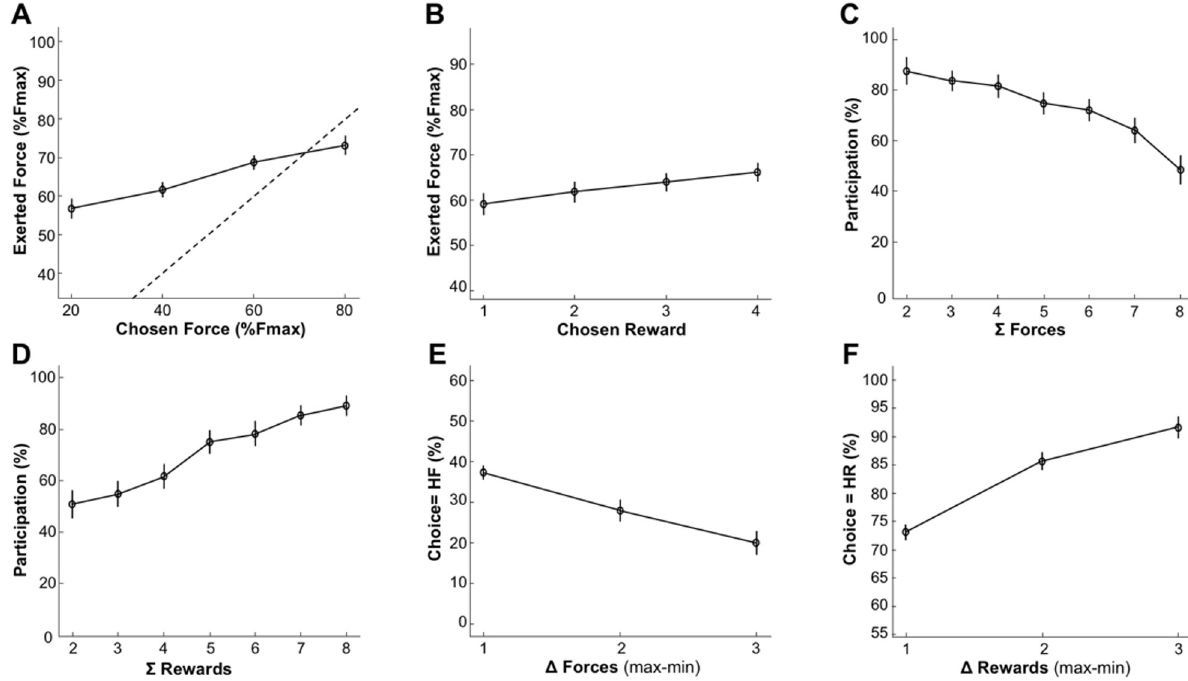
Fig 2. Behavior under placebo condition. Lines and dots represent group-level means (across monkeys), and error-bars represent SEM (across sessions). A . Relationship of exerted force with required force of the chosen option. The force exerted at the peak increased with the required force of the chosen option ( β = 0.06, t (147) = 4.45, p = 1.69 × 10 − 5 ). The dotted line represents the optimal relationship between exerted force and required force (the minimum required force to complete the trial, i.e., the position of the force threshold). B. Relationship between exerted force and expected reward of the chosen option. Reward had a positive influence on the exerted force ( β = 0.02, t (147) = 3.25, p = 1.42 × 10 − 3 ). C-D. Participation (%) to trials as a function of the sum of required forces ( C ) or reward ( D ). C . Participation was negatively modulated by the sum of required forces ( β = − 0.51, t (147) = − 7.93, p = 4.99 × 10 − 13 ) presented in an offer. D. Monkeys’ participation was positively modulated by the sum of rewards ( β = 0.49, t (147) = 6.62, p = 7.36 × 10 − 5 ) presented in an offer. E . Proportion of high-reward choices as a function of the difference in offered rewards between the 2 options (1D-reward conditions). There was a significant effect of the difference in required force on choices ( β = − 1.84, t (147) = − 6.95, p = 1.09 × 10 − 10 ). F. Proportion of high-required-force choices across difference in offered forces (1d-required force conditions). There was a significant contribution of the difference in reward in choices ( β = 2.39, t (147) = 9.44, p = 7.94 × 10 − 17 ). Underlying data can be found in S1 Data. Fmax: maximal force; HF, high force; HR, high reward.